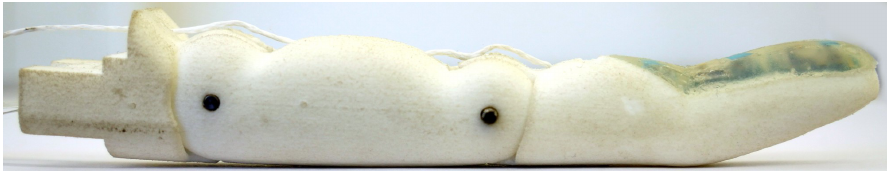
Figure 4. Profile of the ring finger showing a curved design for the individual